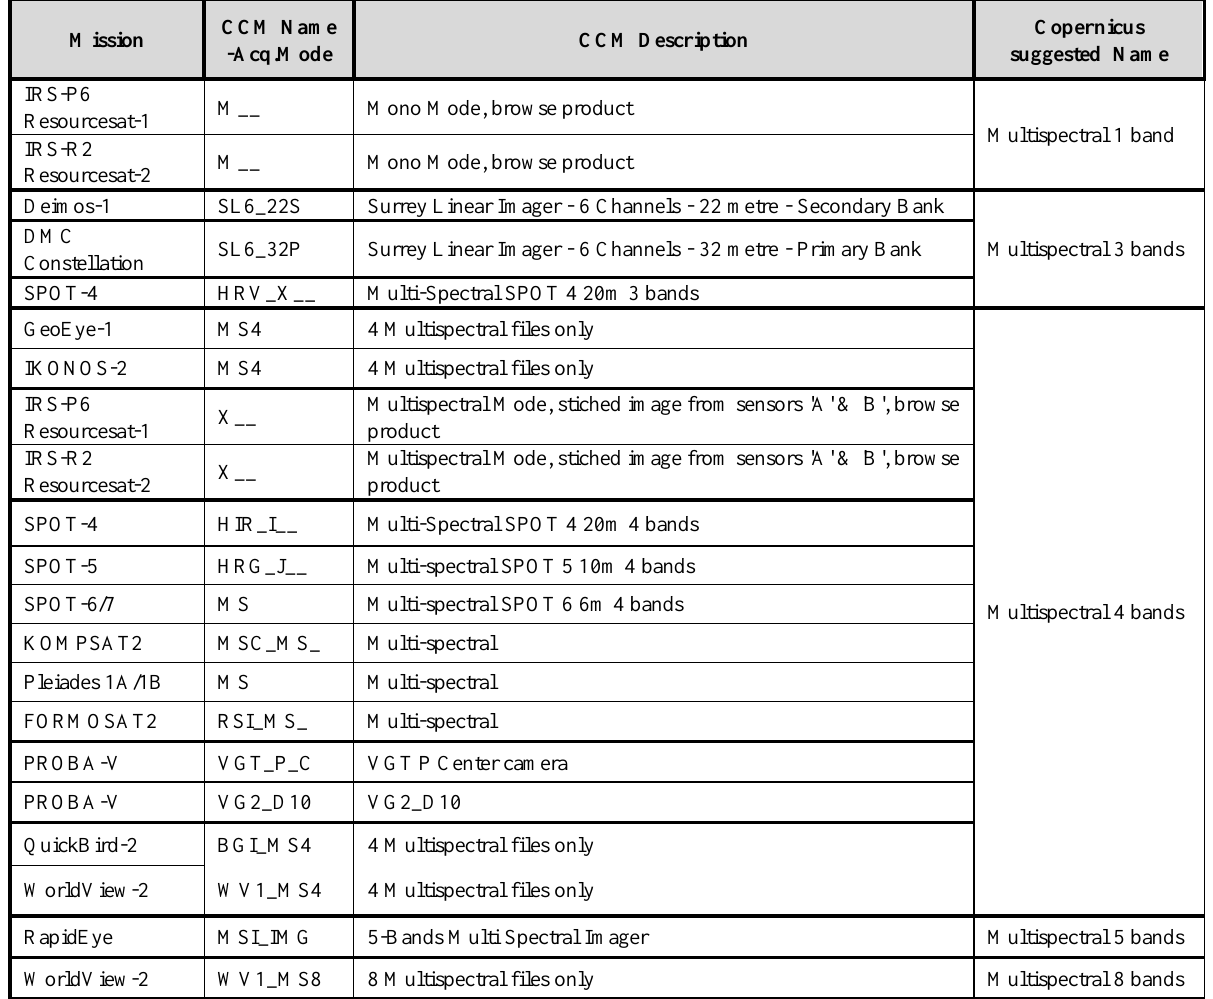
Table 3. Comparison of multispectral product names/codes across different